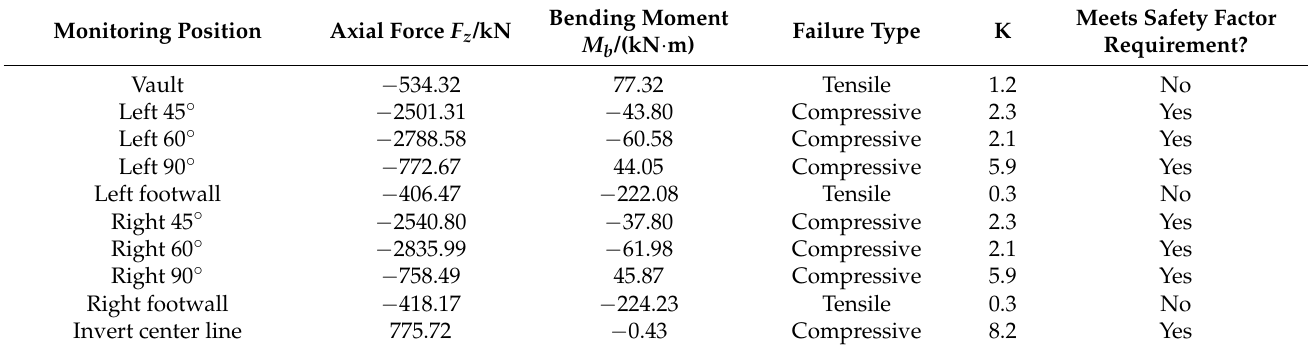
Table 4. Safety factor of each position in the original design scheme.